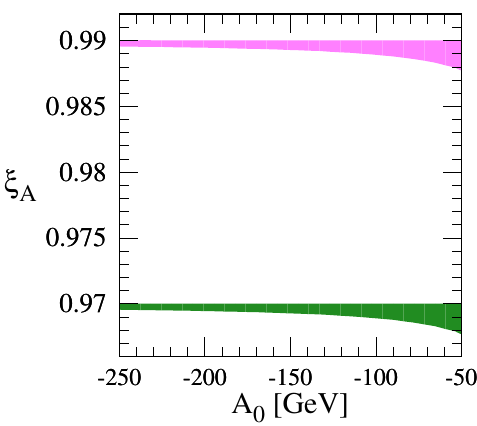
Figure 3 . Graphical presentation of our resonance condition eq. (4.7). The upper line is for c = 0 : 99 while the lower line is for c = 0 : 97. The ratio (cid:24) A deviates less than 2 : 5 input value of c